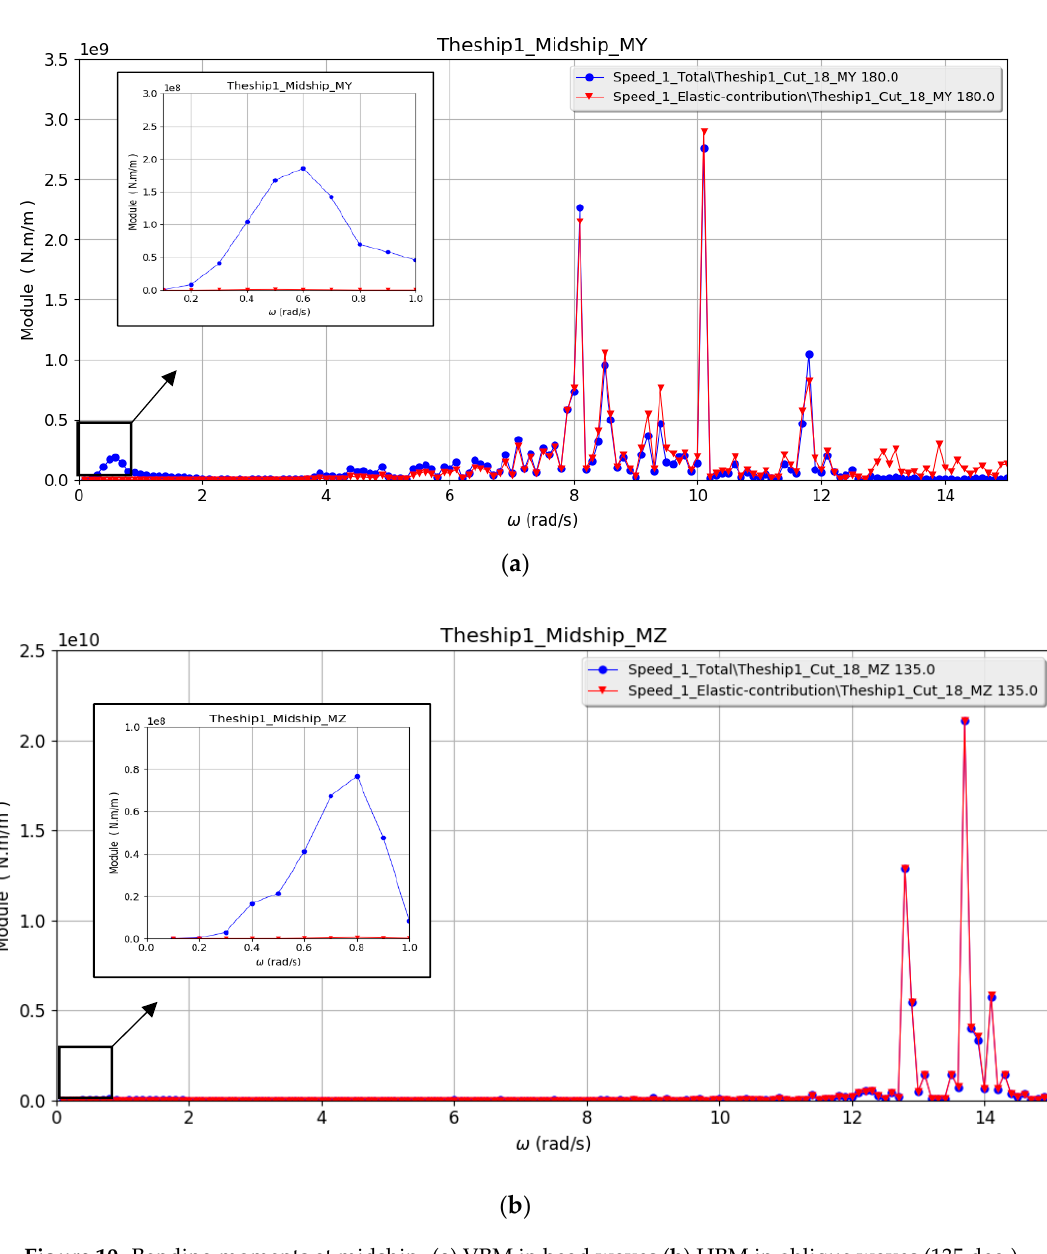
Figure 10. Bending moments at midship. ( a ) VBM in head waves ( b ) HBM in oblique waves (135 deg.).